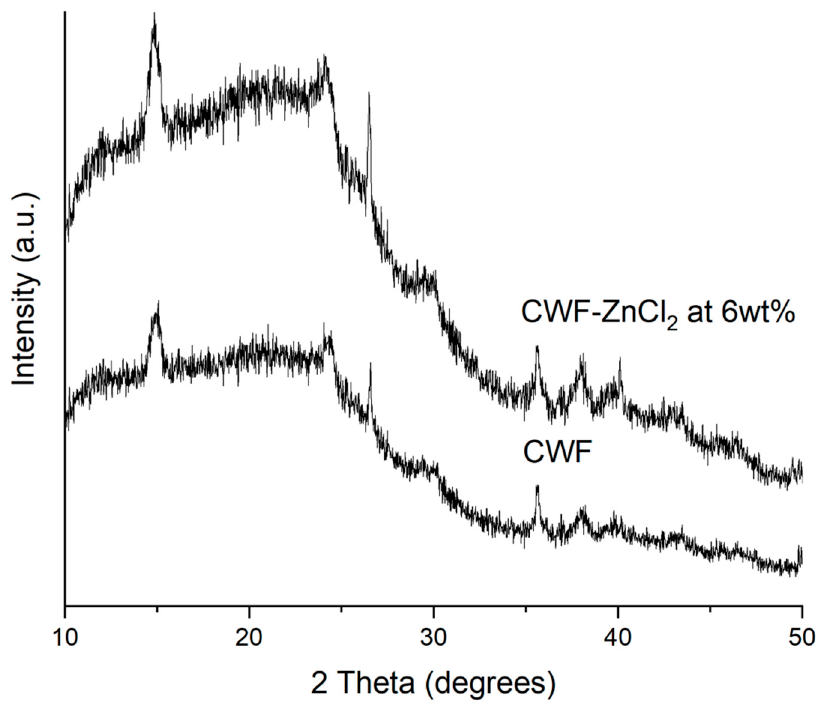
Figure 9. XRD diffractogram of CWF and CWF-ZnCl 2 at 6 wt% ZnCl 2 content.